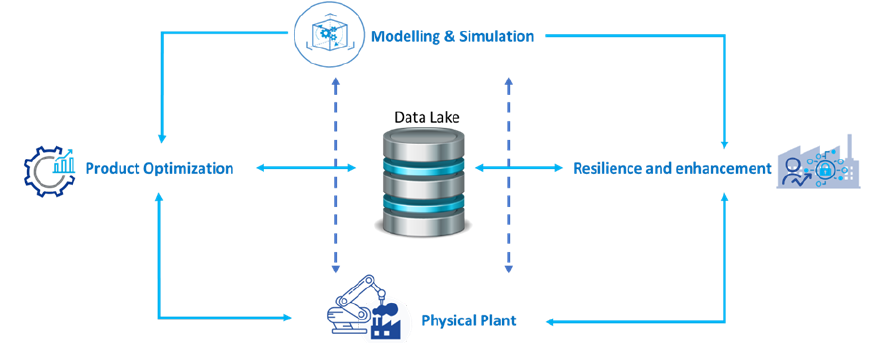
Figure 1. Key capacities of CyberFactory#1.